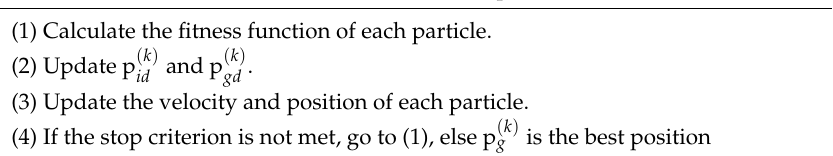
Algorithm 1. The Procedure of Particle Swarm Optimization